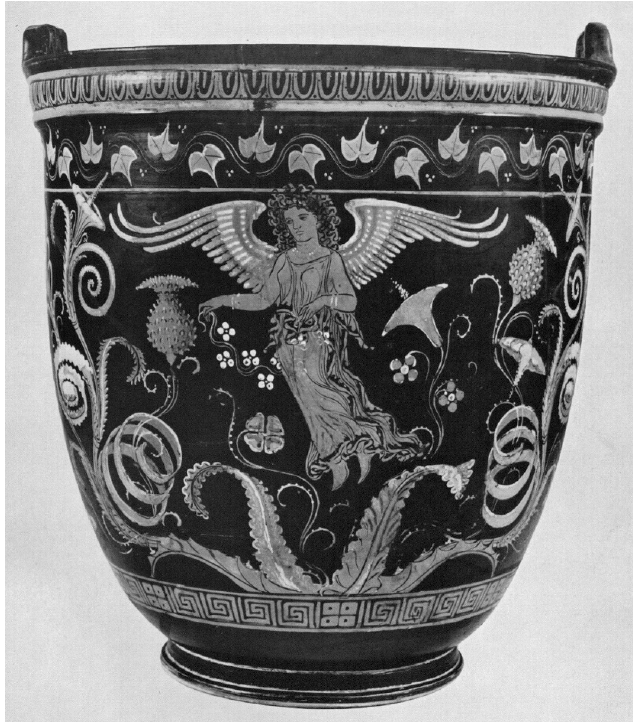
Figure 5. Ruvo, Museo Nazionale Jatta 1372 Apulian situla, Painter of the Dublin Situla, ca. 360–350 B.C. Nike amid flowering tendrils above an acanthus calyx. Photograph provided by the Ministero per i Beni Culturali, Soprintendenza per i Beni Archeologici della Puglia, Archivo fotografico, Taranto.